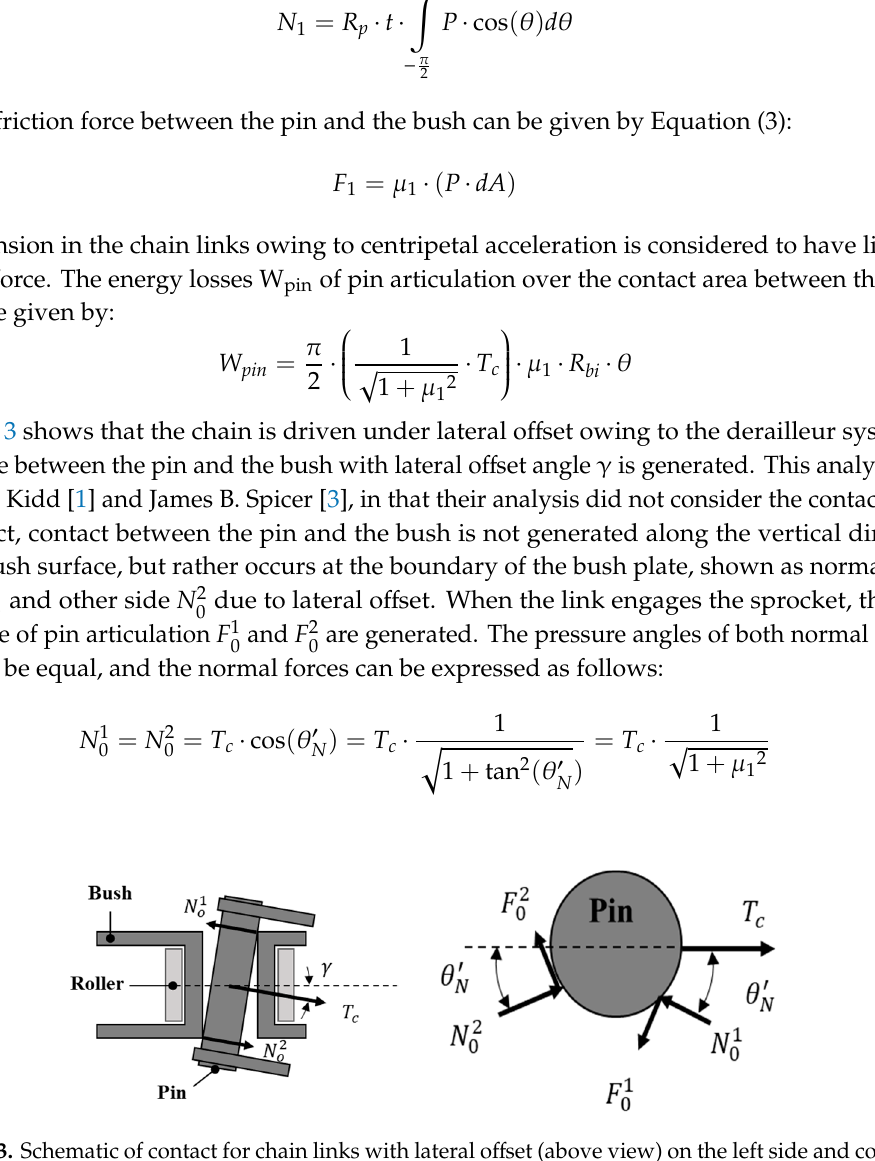
Figure 3. Schematic of contact for chain links with lateral offset (above view) on the left side and contact of pin articulation (side view) on the right side.